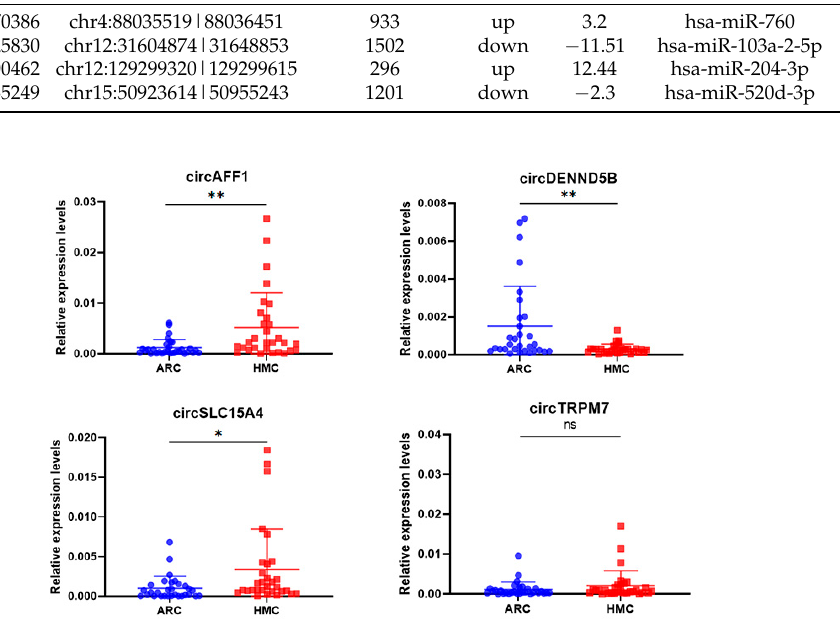
Figure 3. The expression of four selected circRNAs in HMC and ARC lens epithelium samples. RNA was extracted from 30 HMC and 30 ARC lens epithelium samples and used for qPCR analysis of the indicated circRNAs. The expression was normalized to GAPDH. Data were expressed as mean ± SD. ns p > 0.05, * p < 0.05, ** p < 0.01.